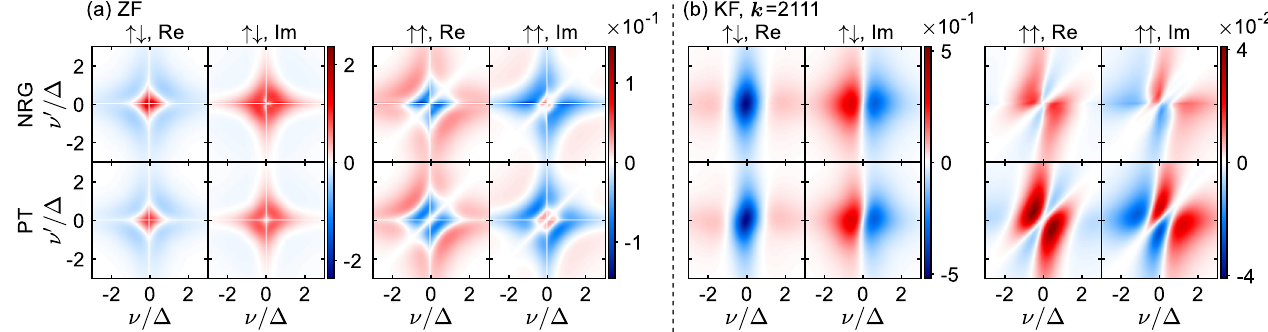
FIG. 5. Weak-coupling benchmark comparison of real-frequency correlators. We show the connected 4 p correlator ð Δ 4 =U Þ G con σσ ω ¼ 0 , obtained by NRG (top row) or second-order perturbation theory (PT) (bottom row), for the weakly interacting AIM ( U= Δ ¼ 1 = 2 , Δ =D ¼ 1 = 10 , T ¼ 10 − 3 D ). For both (a) the ZF and (b) the KF ( k ¼ 2111 ) correlators, the NRG and PT results show very good qualitative agreement. Perfectly quantitative agreement cannot be expected, due to the broadening needed to obtain smooth results. The retarded KF component k ¼ 2111 looks intriguingly different from the ZF correlator.